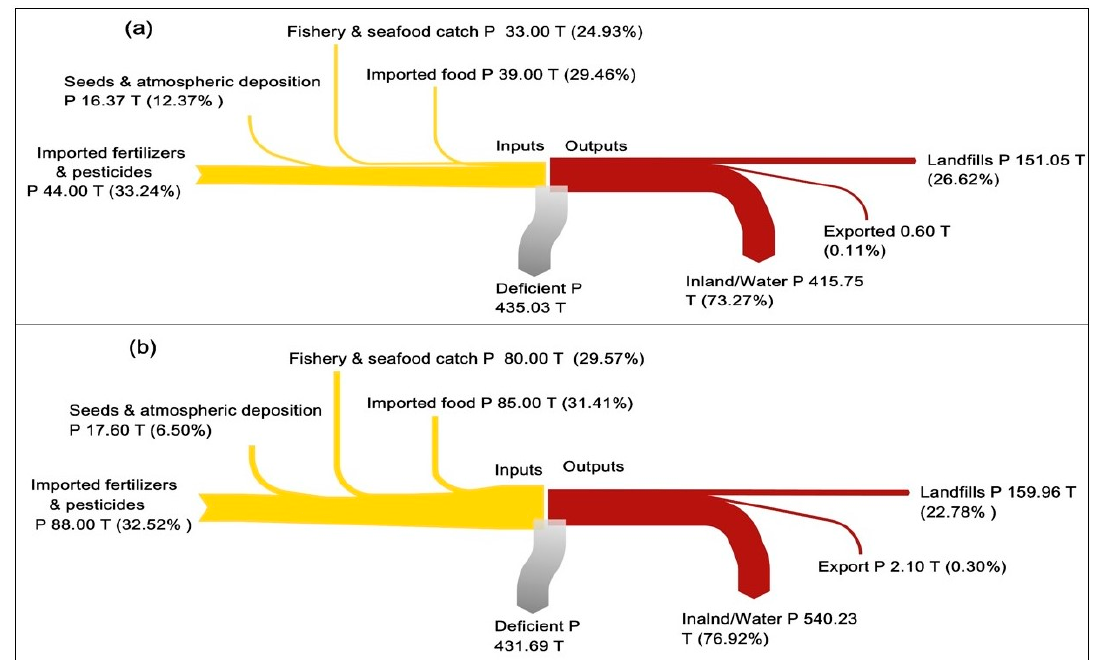
Figure 4. Detailed P inputs and outputs for the overall system in ( a ) 2000 and ( b )